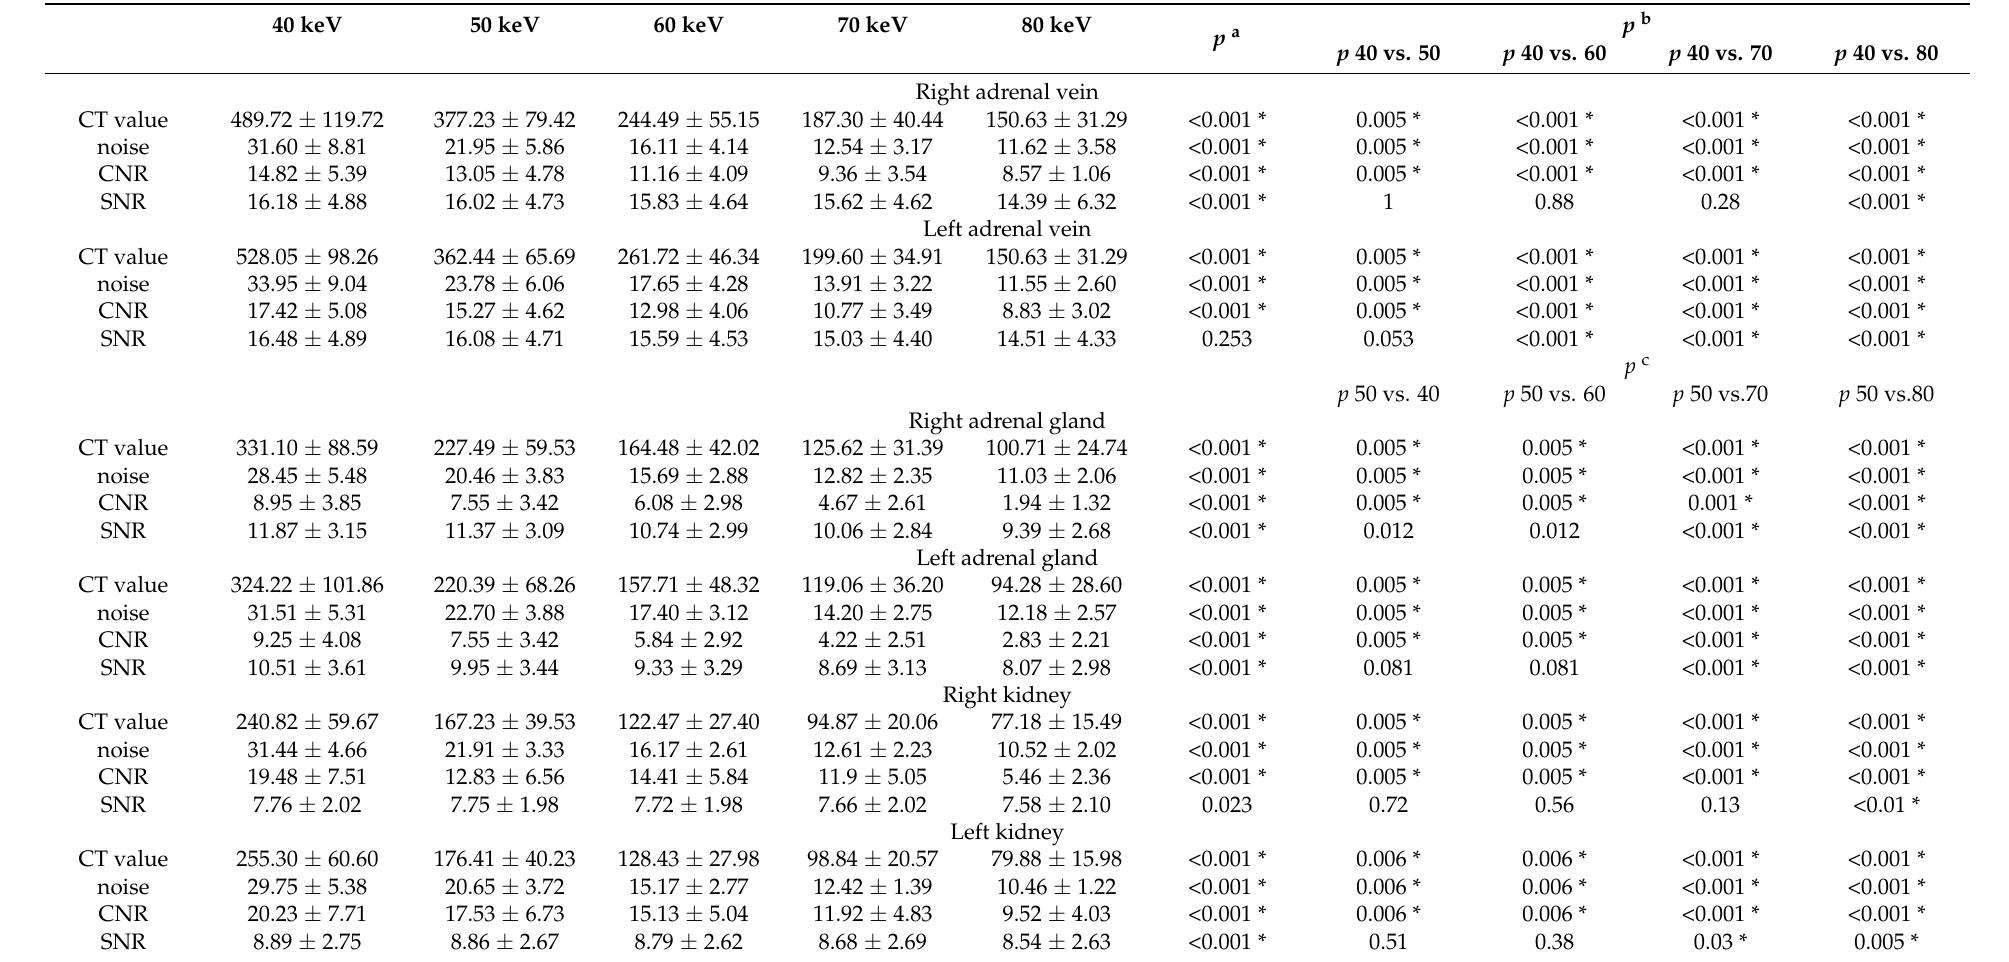
Table 2. CT value, noise, SNR and CNR for the adrenal veins and main abdominal organs in different VMI+